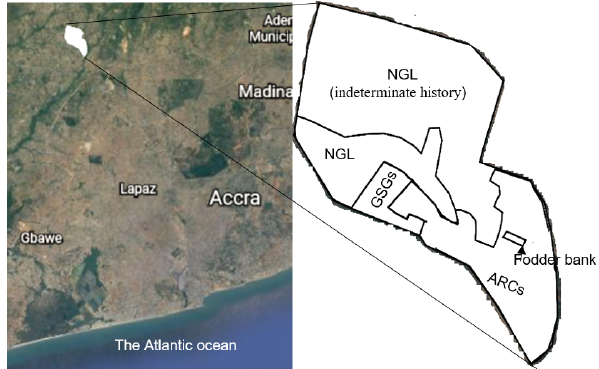
Figure 1. Location and plan of the study site. The native grass- land (NGL) has remained uncultivated since the farm was estab- lished in 1966. The portion of NGL labelled “indeterminate his- tory” was excluded from the study due to high uncertainty associ- ated with its history. The fodder bank consisted of cut–use grasses (CGs), legume herbs (CLHs), legume trees/shrubs (CLTSs) and non-legume trees/shrubs (CNLTSs). ARCs represent arable crop fields. Map from © Google Earth, 2020.